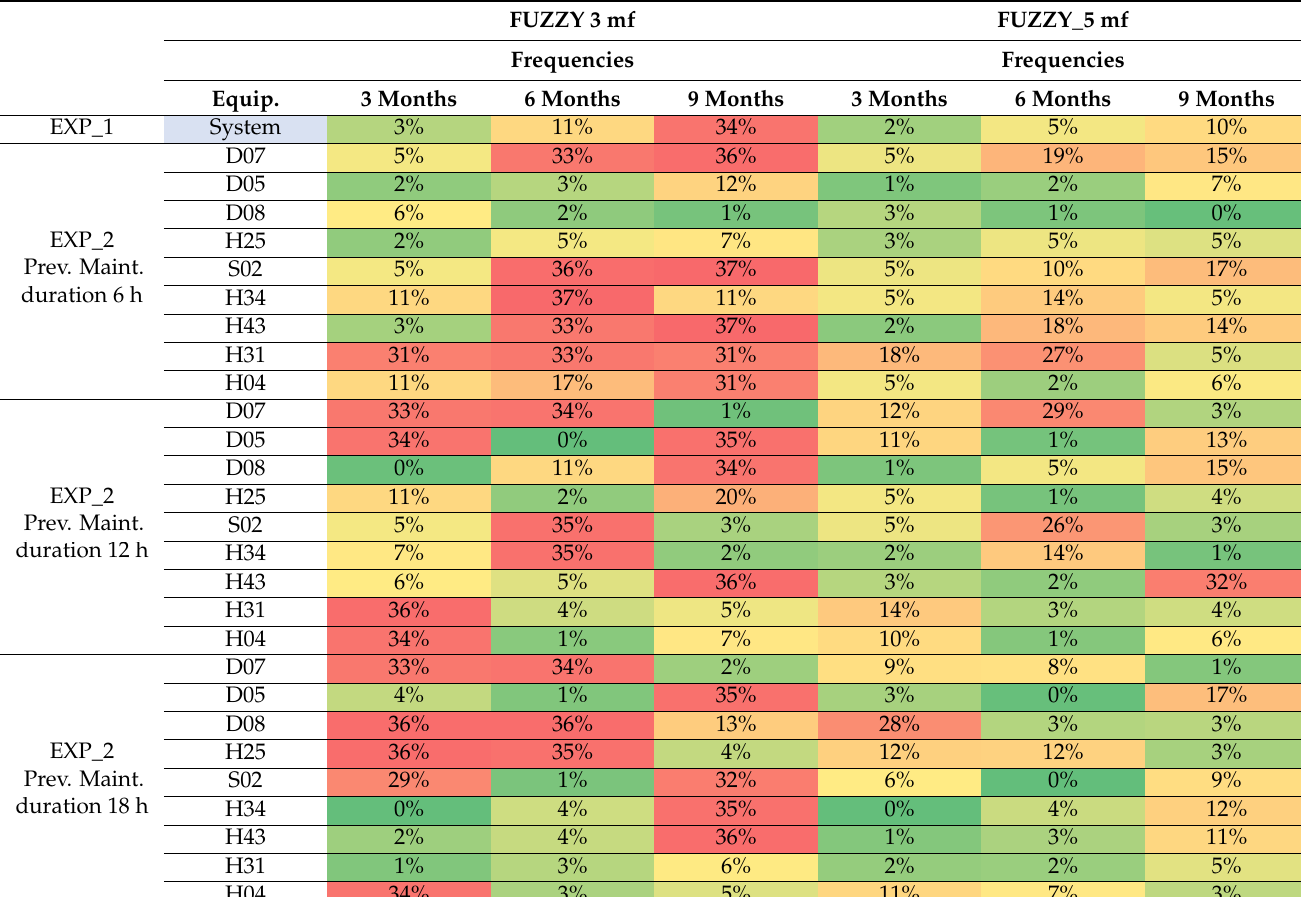
Table 12. Relative errors among defuzzified values and the values obtained through an analytical model (EXP_1 and EXP_2). FUZZY 3 mf FUZZY_5 mf Frequencies Frequencies